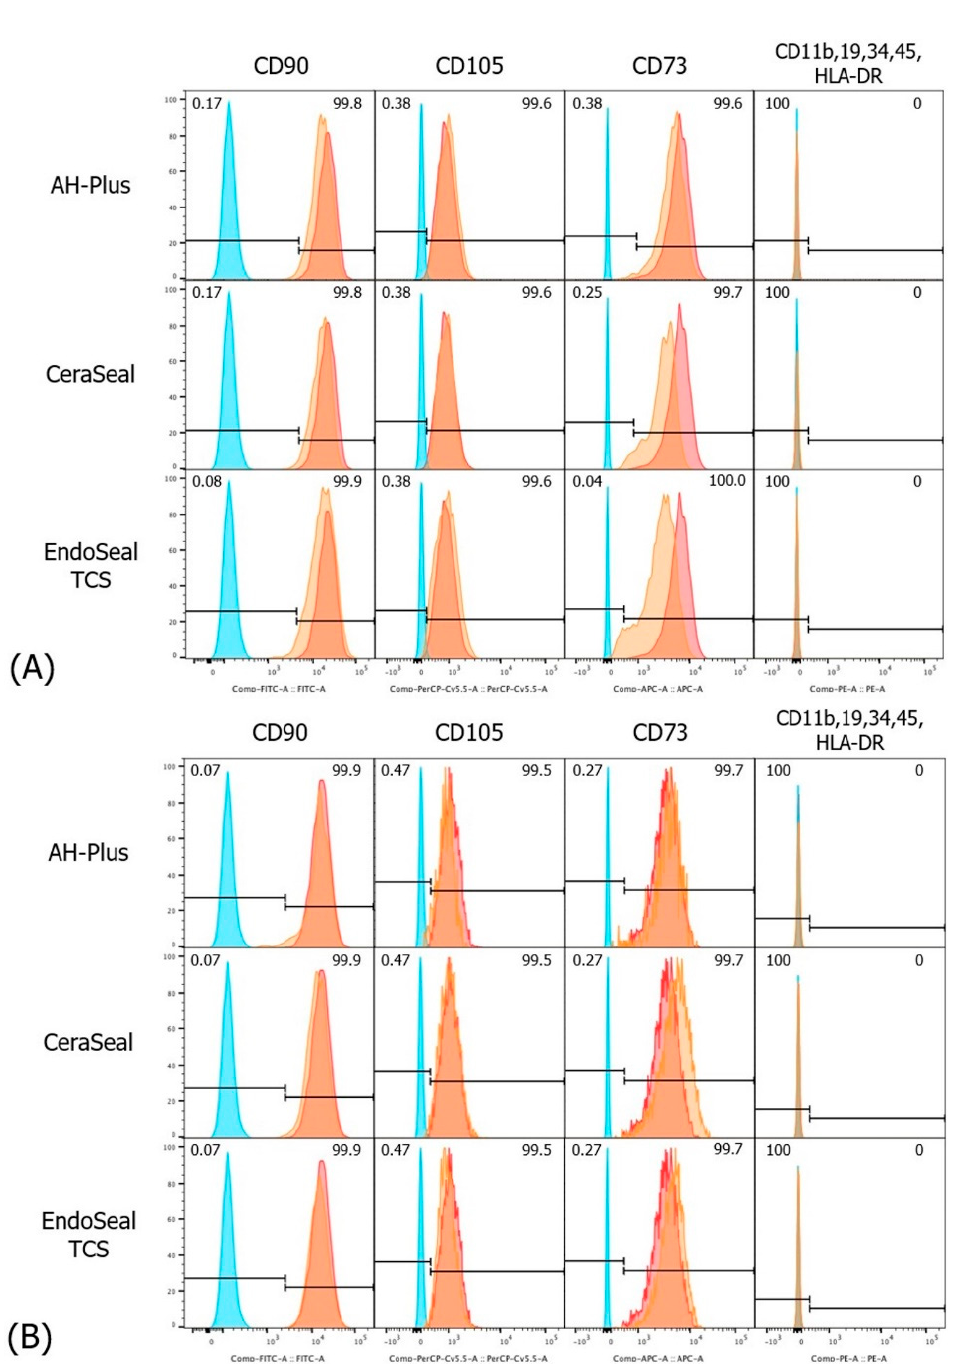
Figure 1. Mesenchymal phenotype expression of human periodontal ligament stem cells (hPDLSCs). ( A ) 3 days, ( B ) 7 days. Blue tracing, Isotype; Orange tracing, experimental group; Red tracing, normal group cultured in normal culture media.